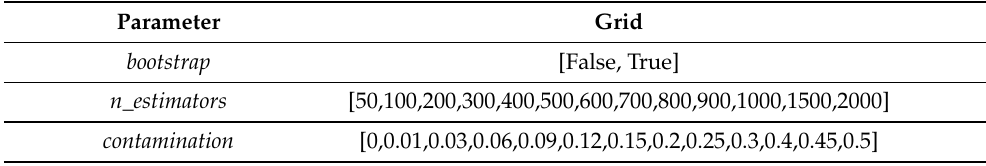
Table 3. Grid parameters of Isolation